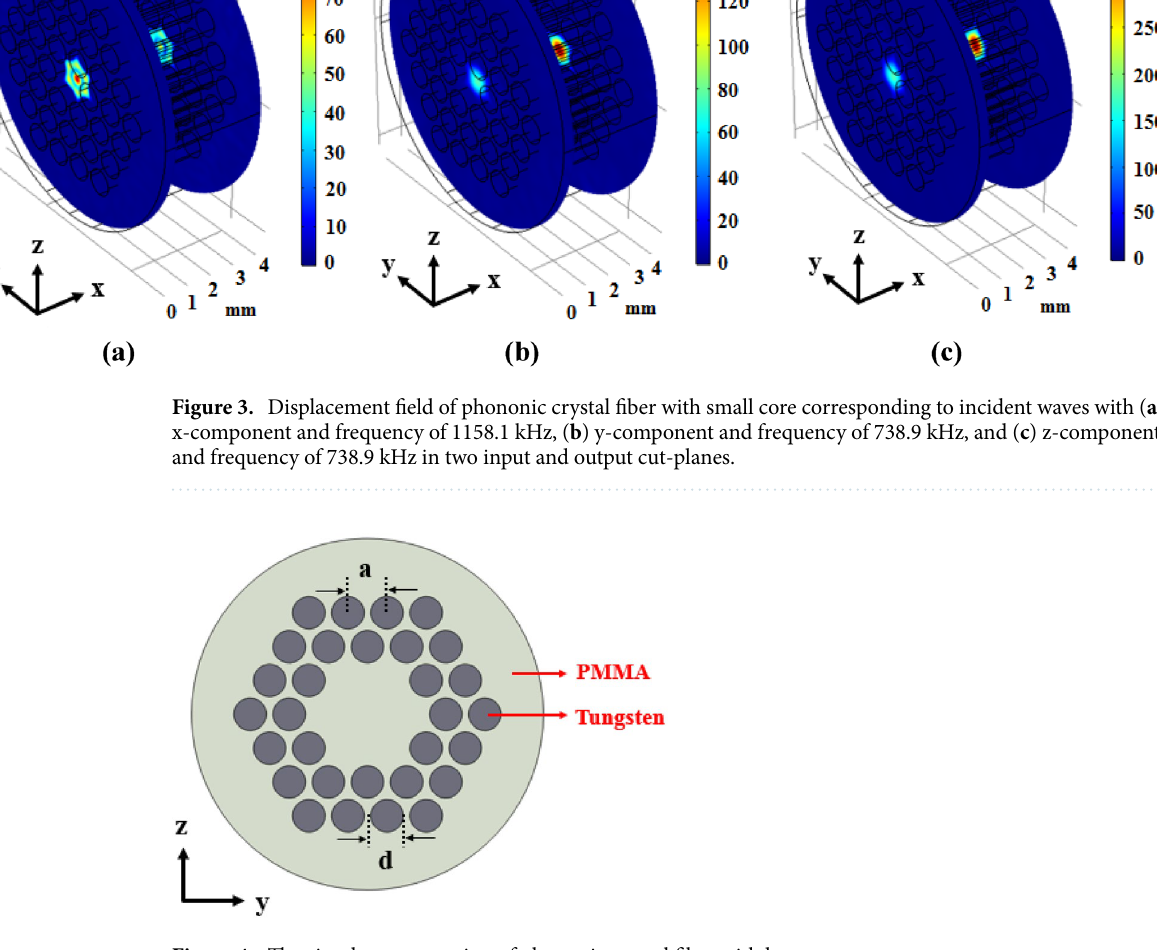
Figure 4. The circular cross section of phononic crystal fiber with large